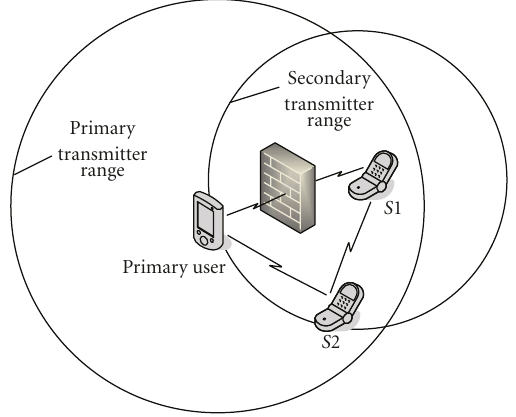
Figure 1: Cooperative spectrum sensing model in cognitive radio